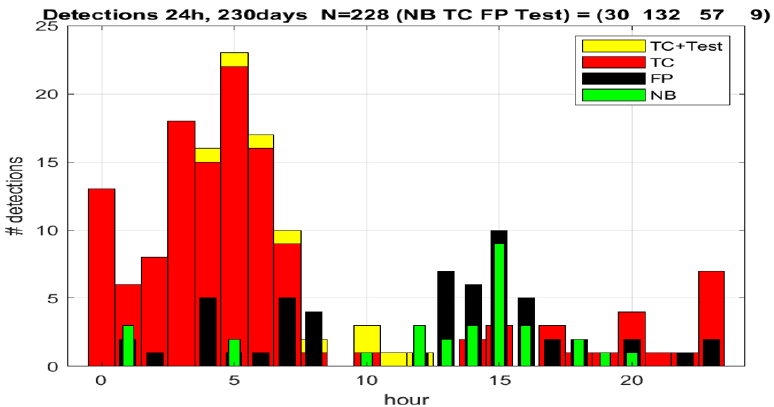
Figure 3. Detection statistics with default and ad hoc parameters. TC — tonic – clonic seizures; FP — false positive; Tests — deliberate seizure imitation; NB — no validation possible. Horizontal axis indicates the hour during 24-h detection summary. Vertical axis gives the numbers of the detected events.